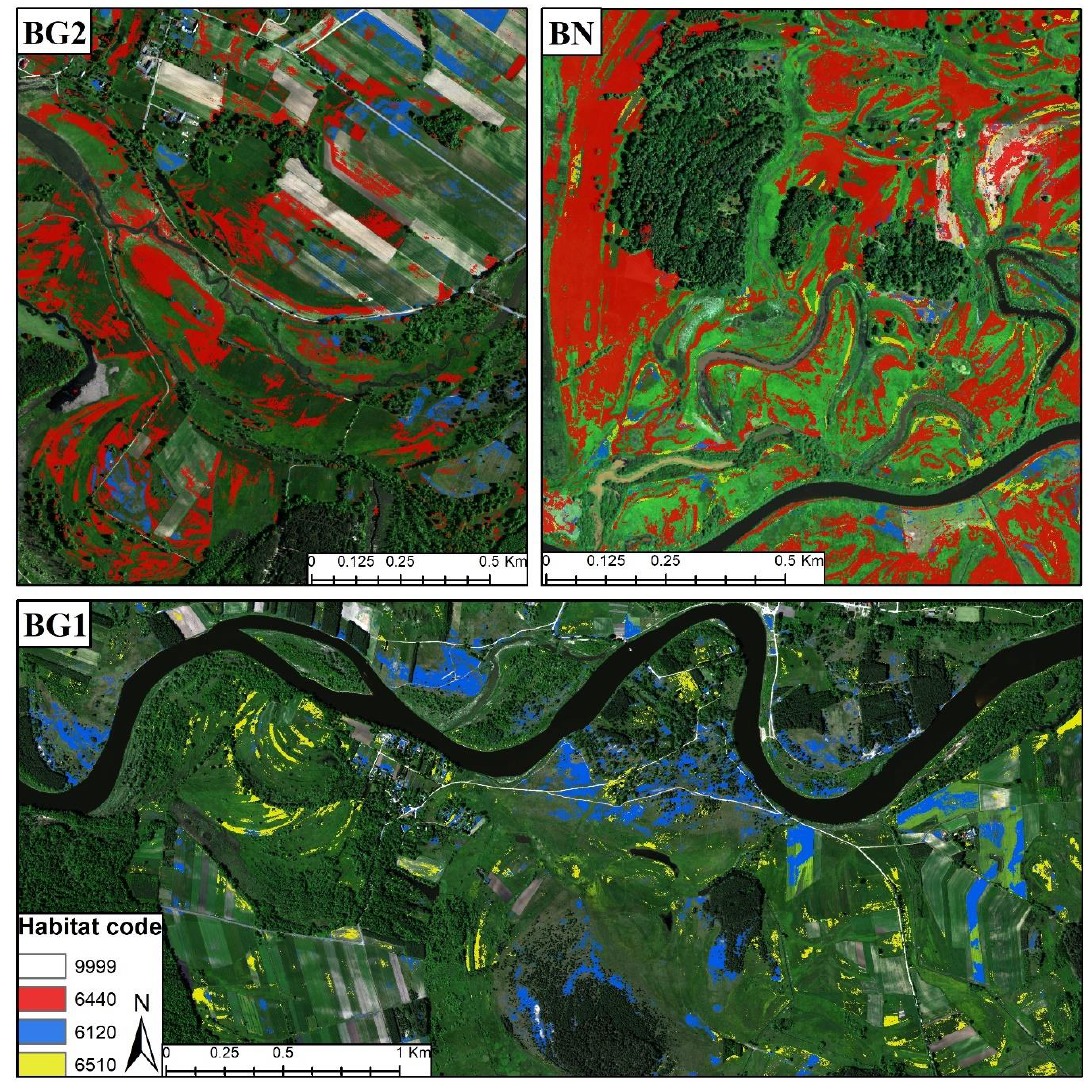
Figure 12. Zooming on the results of the classification maps (for the investigated BG2, BN and BG1 areas) obtained by using the optimal feature selection generalization when considering all study areas together (Exp.3b).